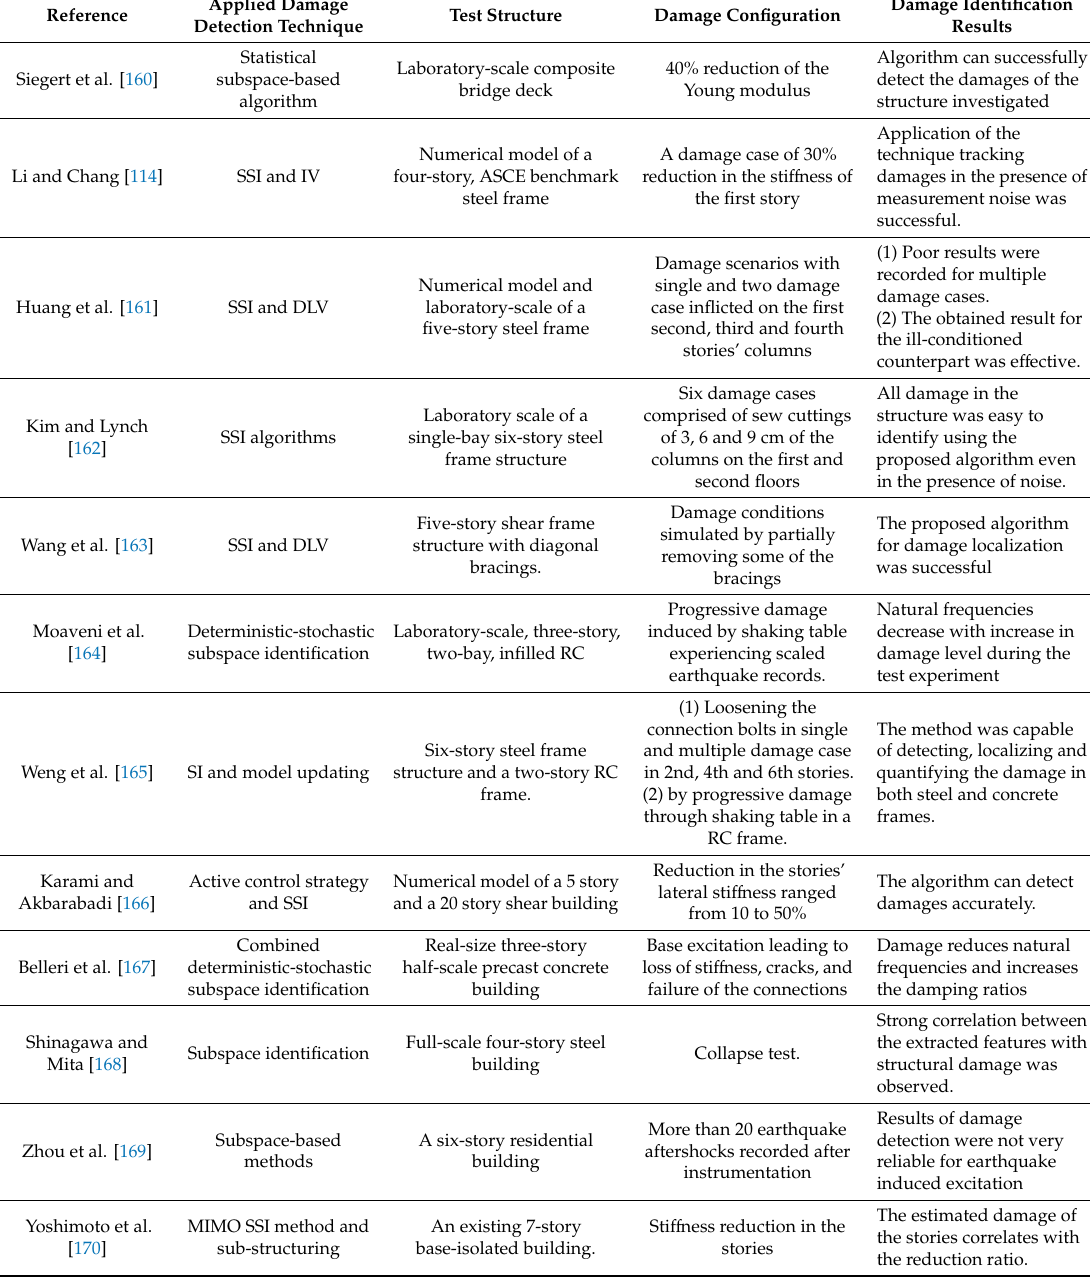
Table 8. Application of SSI algorithms for damage detection of three-dimensional (3D) frames and